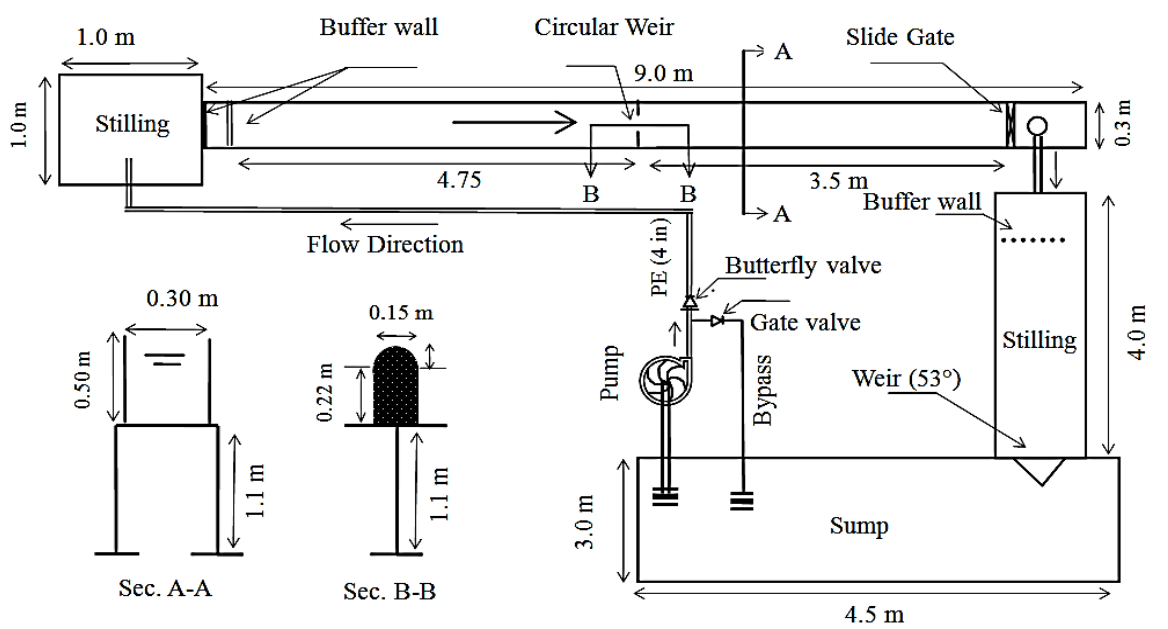
Fig. 2. Plan view of experimental setup (Unit: